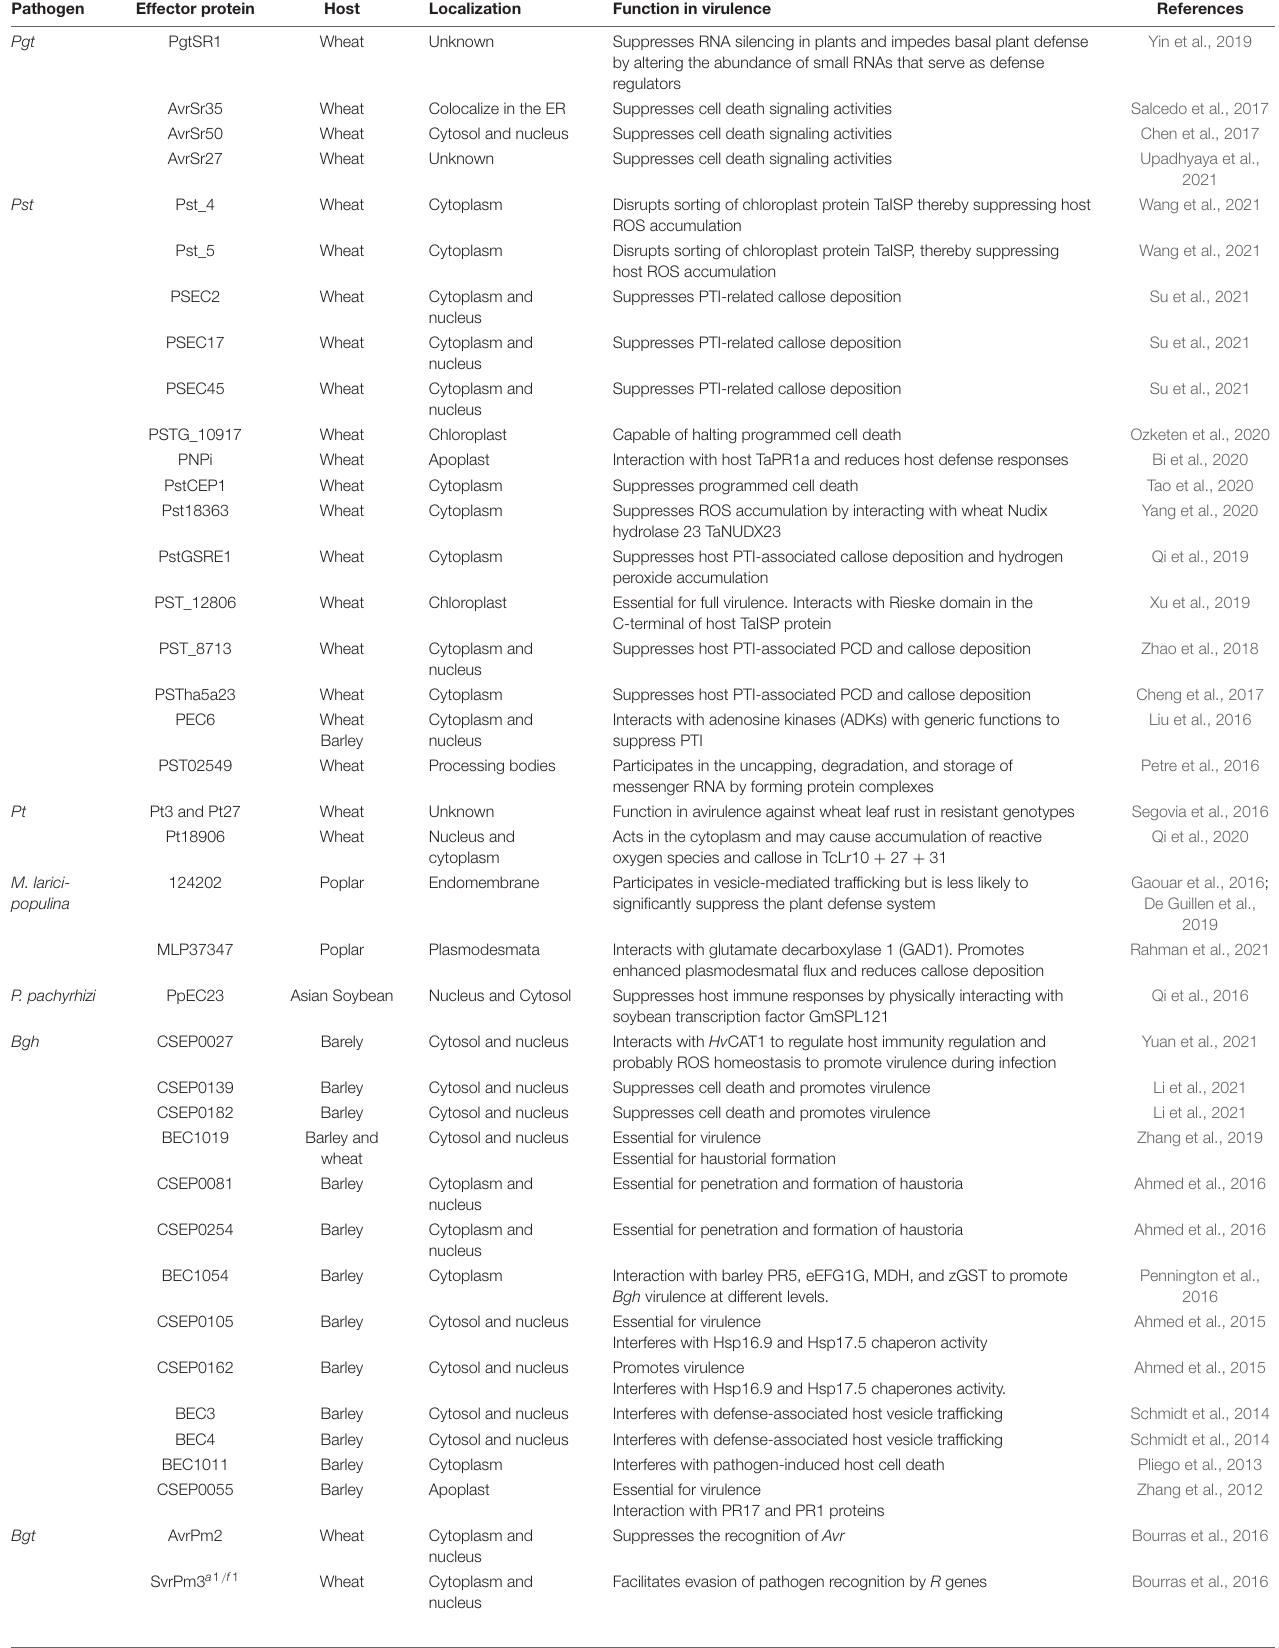
TABLE 2 | Biotrophic plant fungal pathogens effectors involved in the manipulation of host reaction. Pathogen Effector